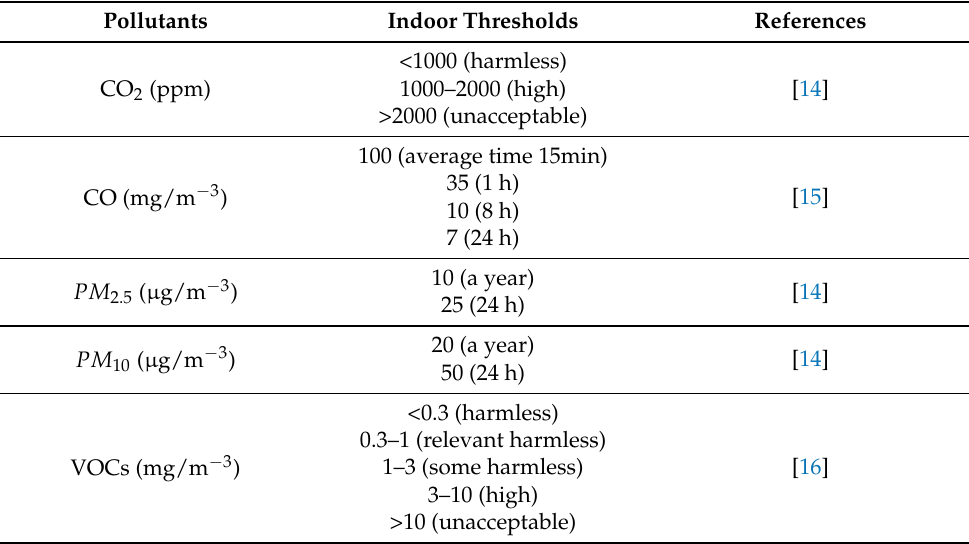
Table 1. The most common indoor environmental air pollutants and their exposure thresholds.